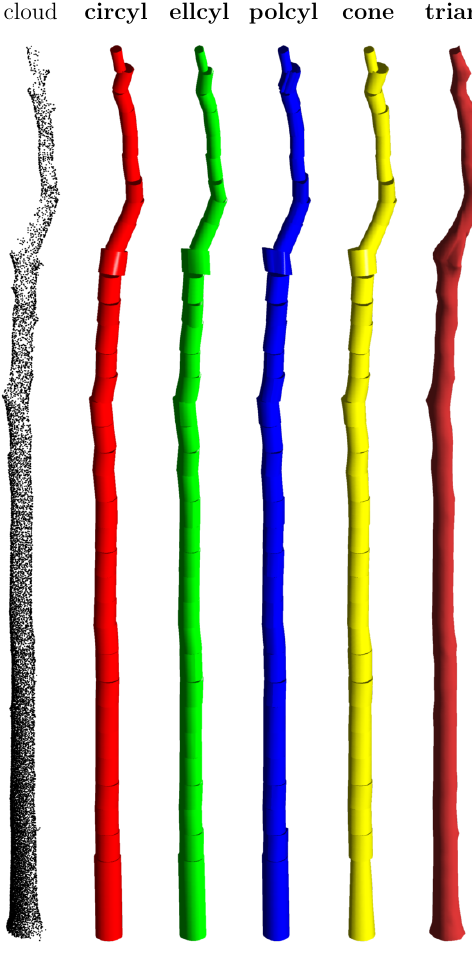
Figure 16. Point cloud (thinned) and reconstructed models of measured Stem 5. Table 4. Reconstruction results for the measured stems. Maximum and average dbh error in percentages and standard deviation ( σ ), the average of the standard deviations for the individual stems ( σ ) in pp and the average distance d from the measurements to the model t avg surface in cm. circyl ellcyl polcyl cone